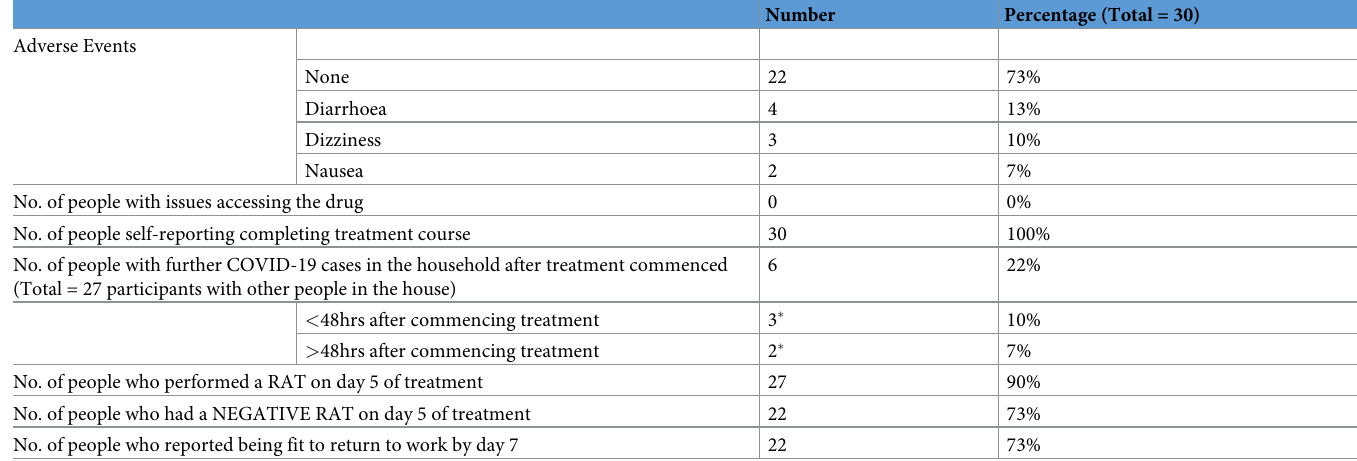
Table 2. Outcomes.